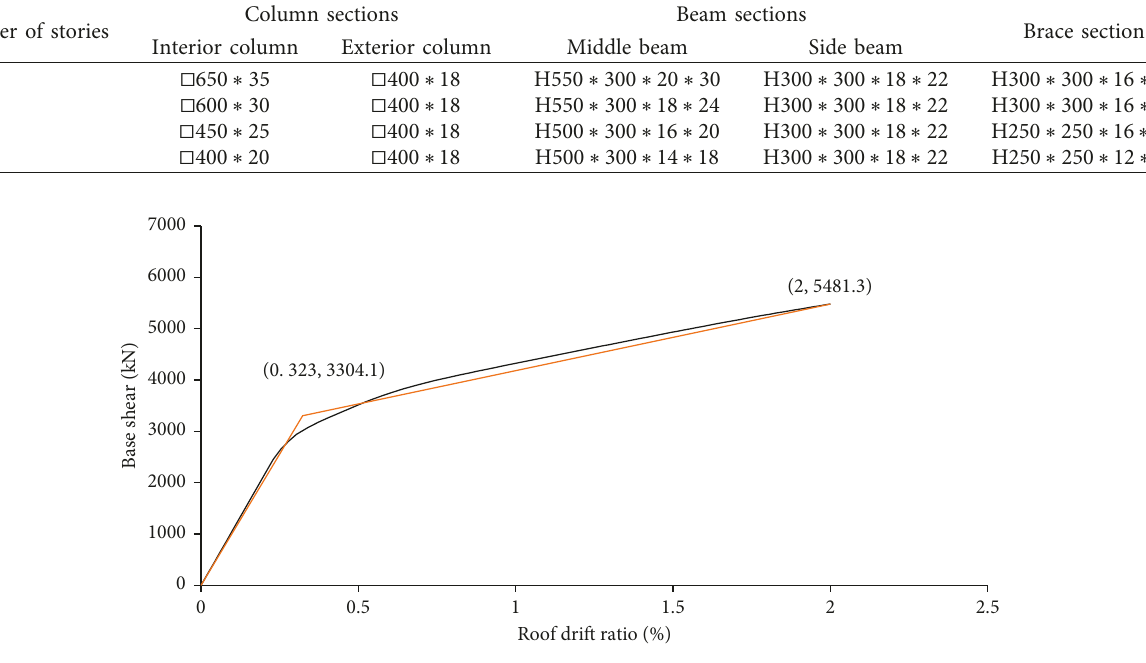
Figure 9: Pushover curve of the 10-story